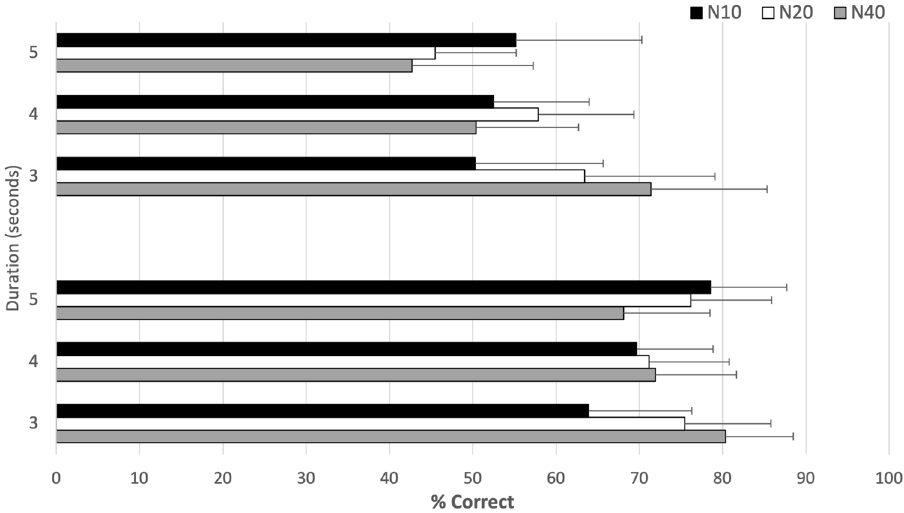
Figure 2. Percentage of correct responses as a function of number of steps ( N10 , N20 , N40 ) for the three duration conditions (3s, 4s, and 5s) for Experiment 1 (progress bars) and Experiment 2 (throbbers). Errors bars show CI at